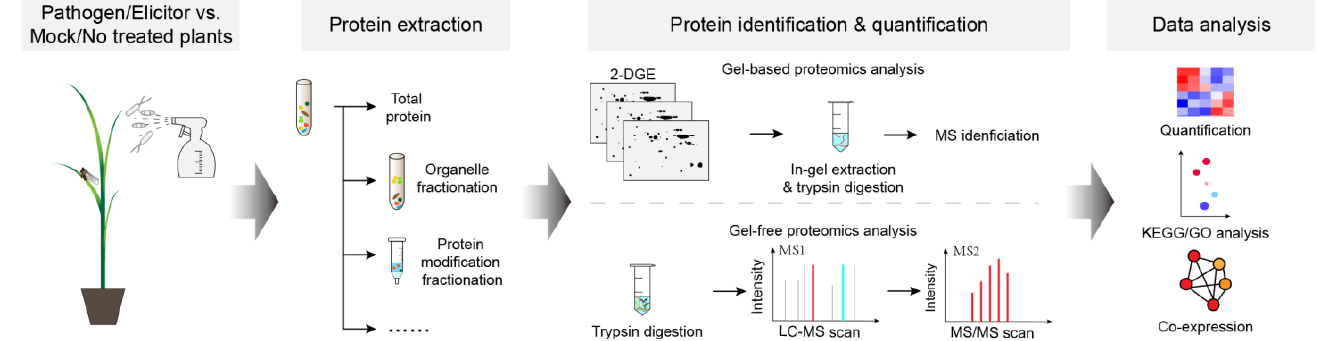
Figure 1. Workflow of proteomics investigation of plant – microbe interactions. Rice plants are inoculated with bacterial, fungal, and viral pathogens through a spray, syringe infiltration, friction, and/or insect-mediated inoculation. Infected tissues are used for protein extraction. In additional to total protein extraction, organelle fractionation, enrichment of post-transcriptional modifications, and other extraction methods are being used to improve the resolution and detection of low-abundance proteins or proteins with different modifications. Extracted proteins are then subjected to protein identification and quantification with gel-based and gel-free proteomics analyses. In the gel-based proteomics approach, protein samples are separated by two-dimensional gel electrophoresis (2-DGE), and protein spots are quantified with in silico methods. The differentially expressed protein spots are identified after in-gel extraction and digestion. For the gel-free proteomics approach, proteins are directly digested and identified by MS/MS approach. Bioinformatic approaches such as heatmaps, KEGG/GO analysis, and co-expression network establishment are further performed for the graphical representation of the obtained